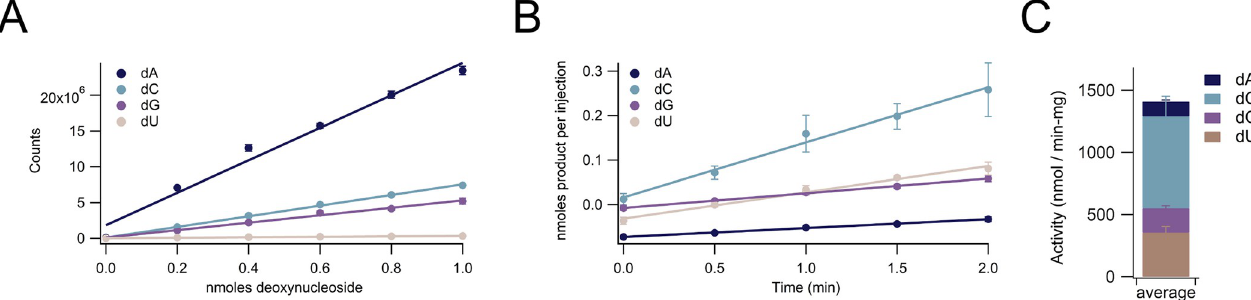
Fig 7. Activity of E . coli class Ia ribonucleotide reductase reducing all four ribonucleotides simultaneously in the presence of specificity effectors dATP, dGTP, and TTP and activity effector ATP. (A) Standard curves of all four ribonucleotides mixed together in concentrations of 0–100 μ M (10 μ L injections). (B) Activity graphs of all four ribonucleotide products being produced simultaneously over two minutes. (C) Bar graph showing production of each of the four deoxyribonucleotide products. The dU activity above condition contained Trx (30 μ M), TrxR (0.5 μ M), NADPH (200 μ M), ATP (3000 μ M), dATP (500 μ M), TTP (250 μ M), dGTP (100 μ M), CDP (70 μ M), UDP (50 μ M), GDP (200 μ M), ADP (110 μ M), NrdA (0.1 μ M dimer), and NrdB (0.5 μ M dimer). Total ion chromatogram (TIC) and individual multiple reaction monitoring (MRM) curves are shown in S4 Fig.